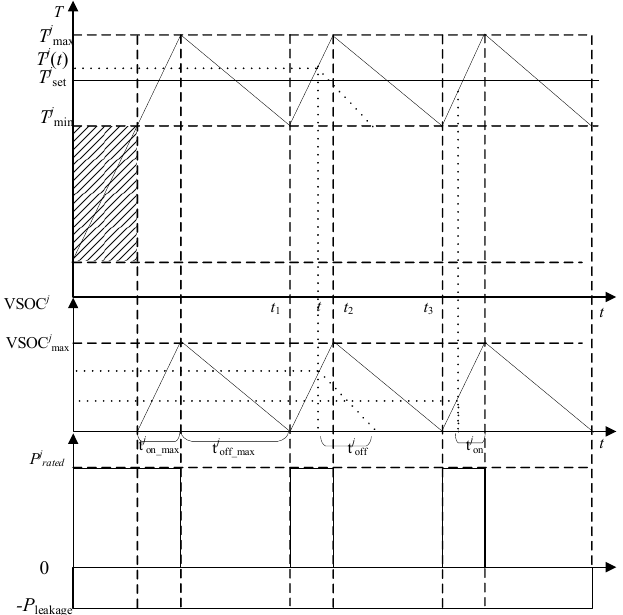
Figure 7. The relationship between linearized temperature curve, virtual state of charge (VSOC) curve and electric